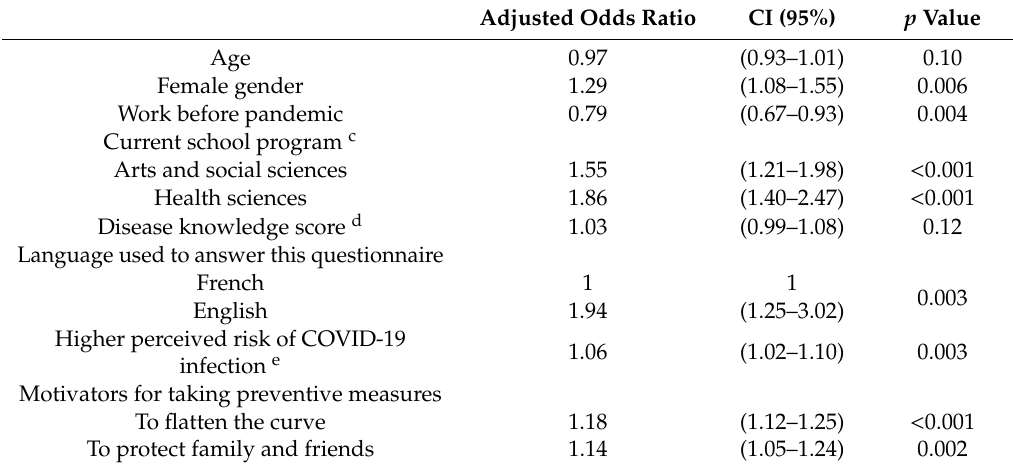
Table 3. Factors associated with the observance of preventive measures a,b